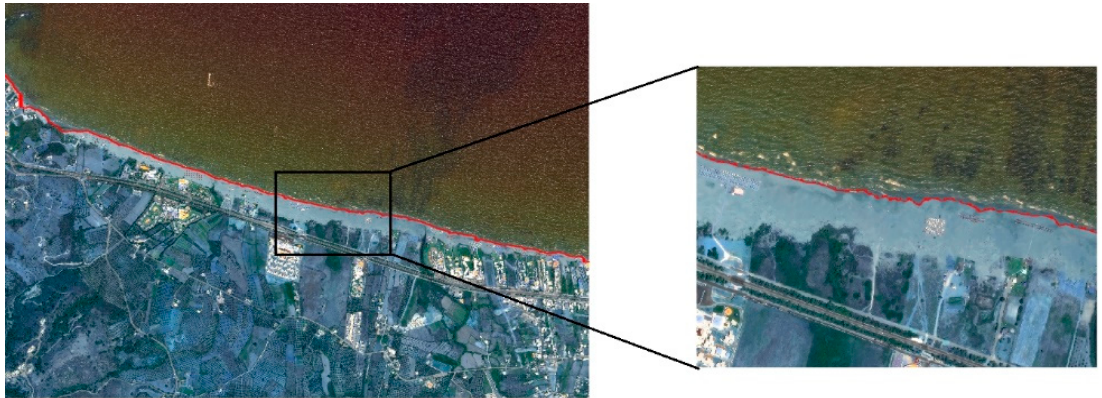
Figure 12. Estimation of the coastline, using a Satellite image.